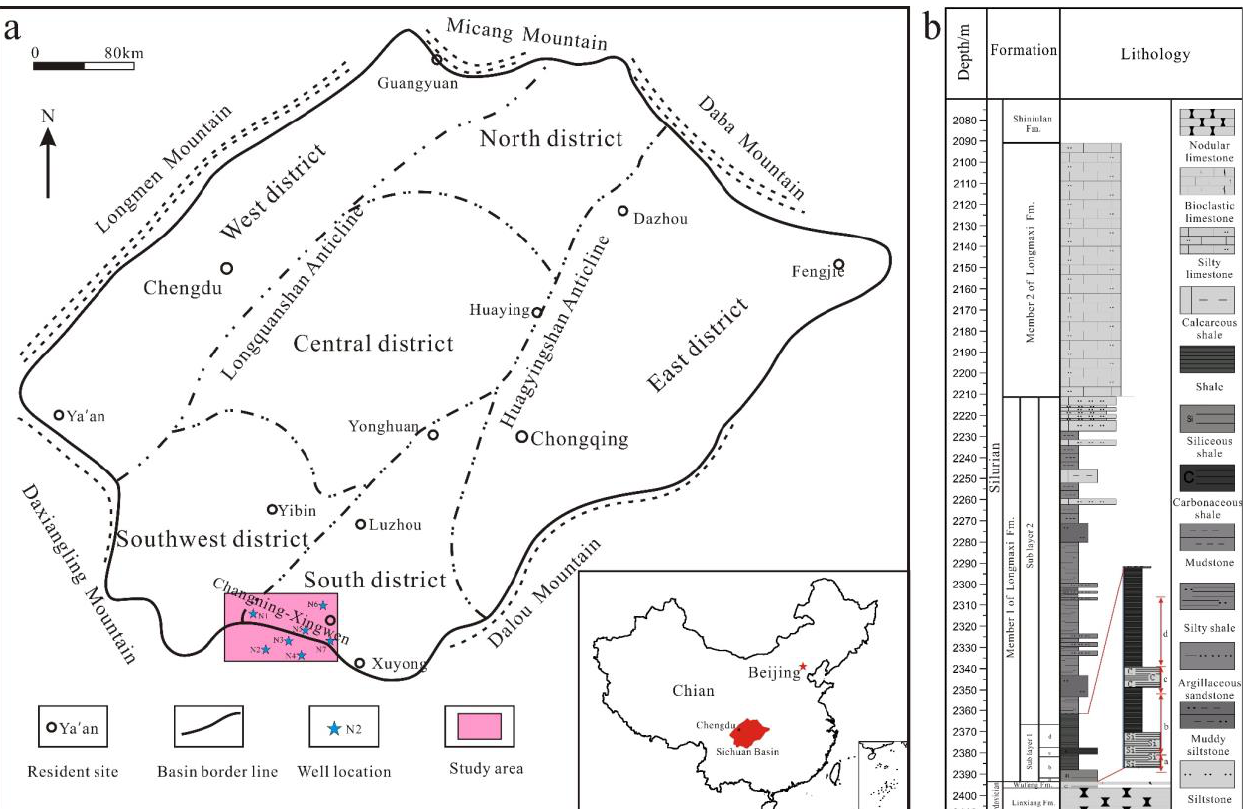
Figure 1. ( a ) Location of the study area in the Sichuan Basin (Modified from [46]); ( b ) Stratigraphic of the Longmaxi Formation in well N3.